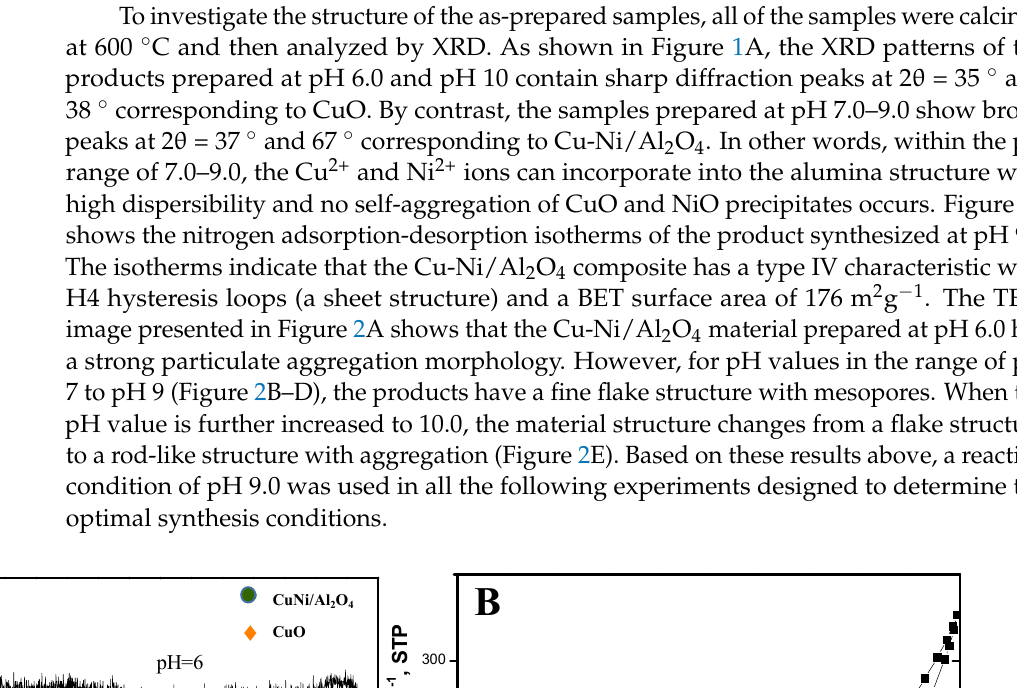
Table 1. Residual concentrations of copper and nickel ions in filtrate at different pH values.